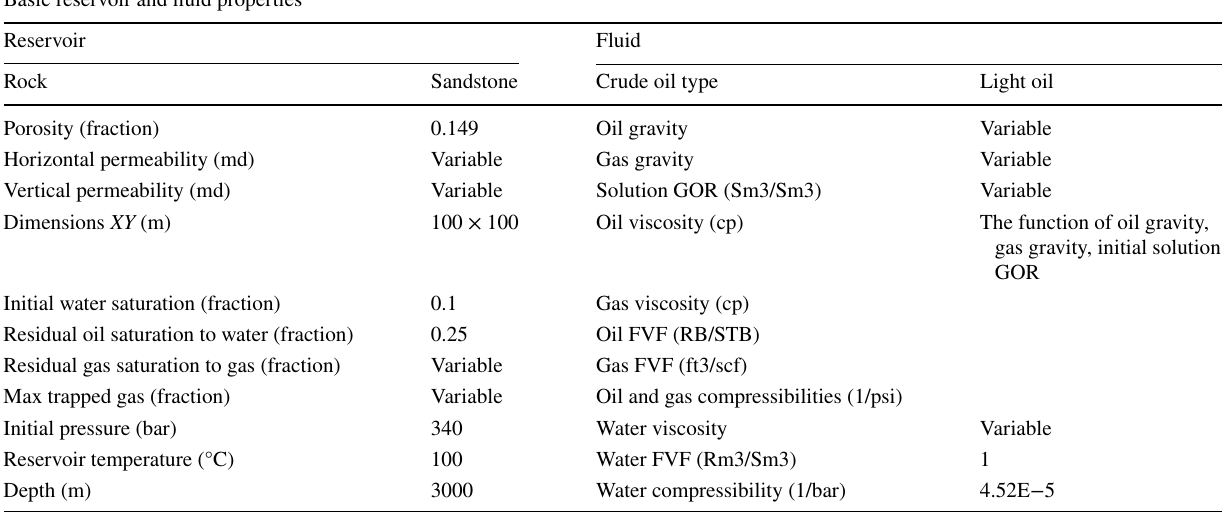
Table 1 Reservoir model input data